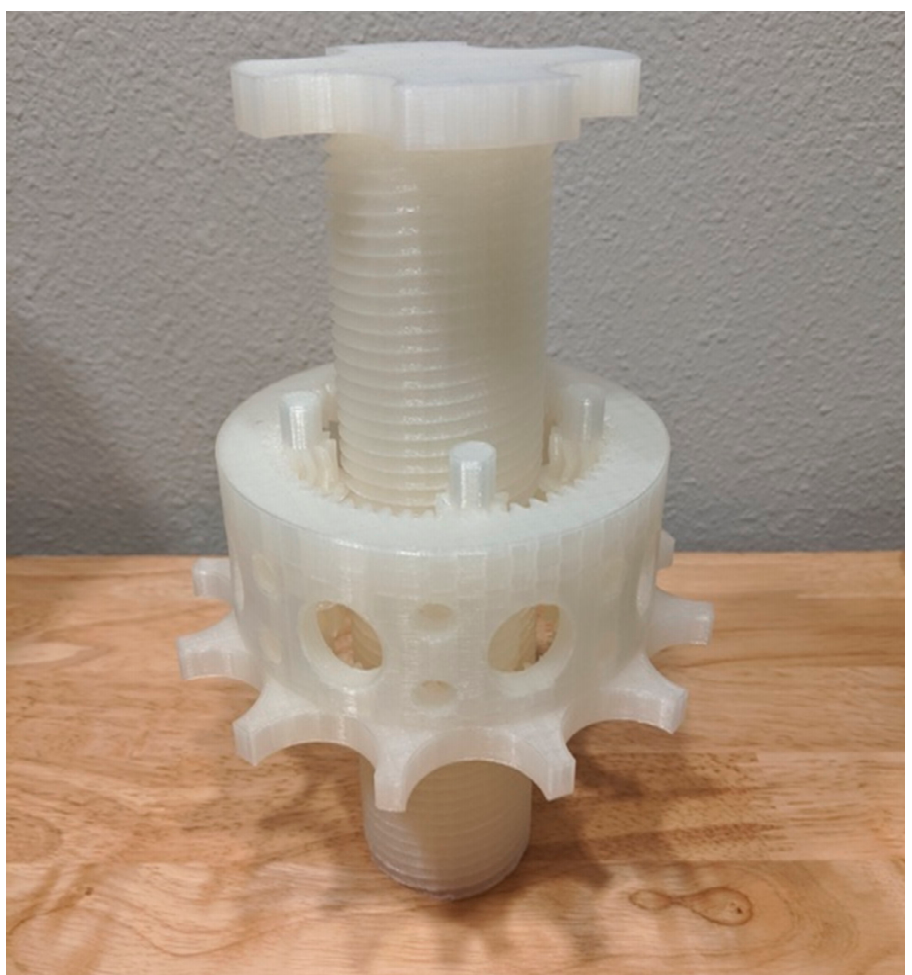
Figure 1. Fully 3D-printed and assembled roller screw assembly. Printed on an open source Prusa Mk3S in natural PLA at 0.2 mm layer